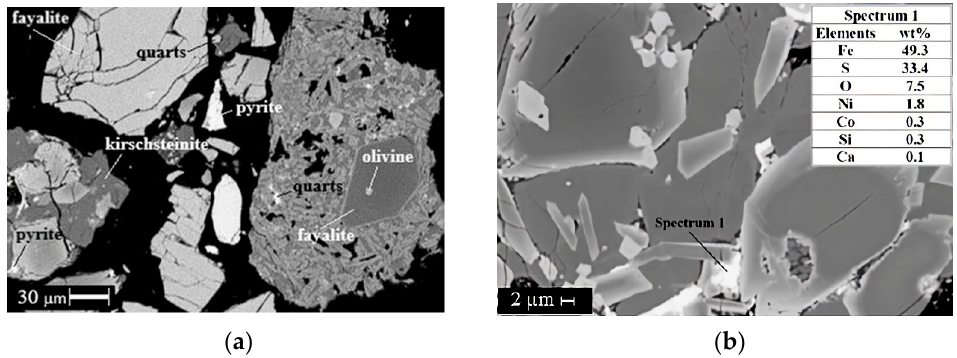
Figure 4. SEM micrograph of slag showing components of the slag: ( a )—sample 807, ( b )—sample